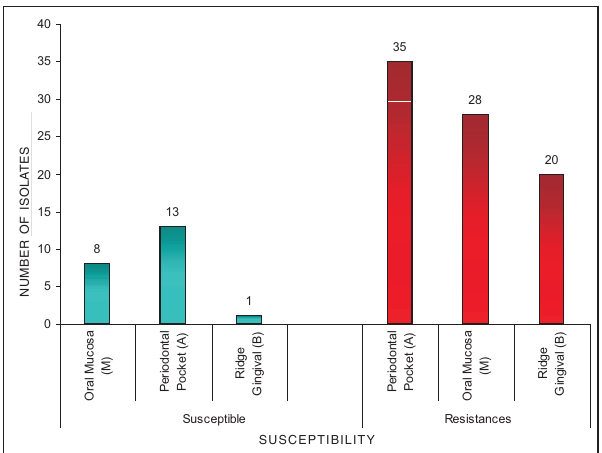
Fig. 4a - Susceptibility of C. albicans isolates to Amphotericin B for sites